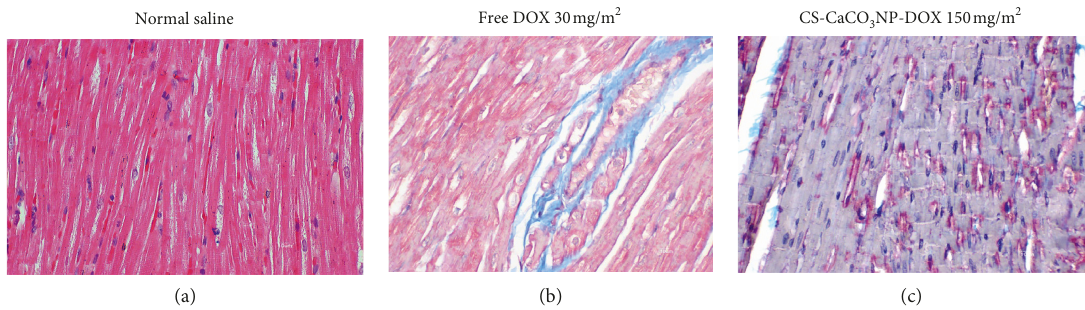
Figure 10: Photomicrograph of the myocardium. (a) Myocardium of the dogs given normal saline showing the normal morphological ar- chitecture of myocardial fibres. (b) Free DOX 150mg/m 2 showing collagen deposit within the interstitial myocardial space of myocardial fibres. (c) CS-CaCO 3 NP-DOX 150mg/m 2 showing basophilic cardiomyocytes with the myocardial fibres (Masson’s trichrome). Scale bar 10 µ